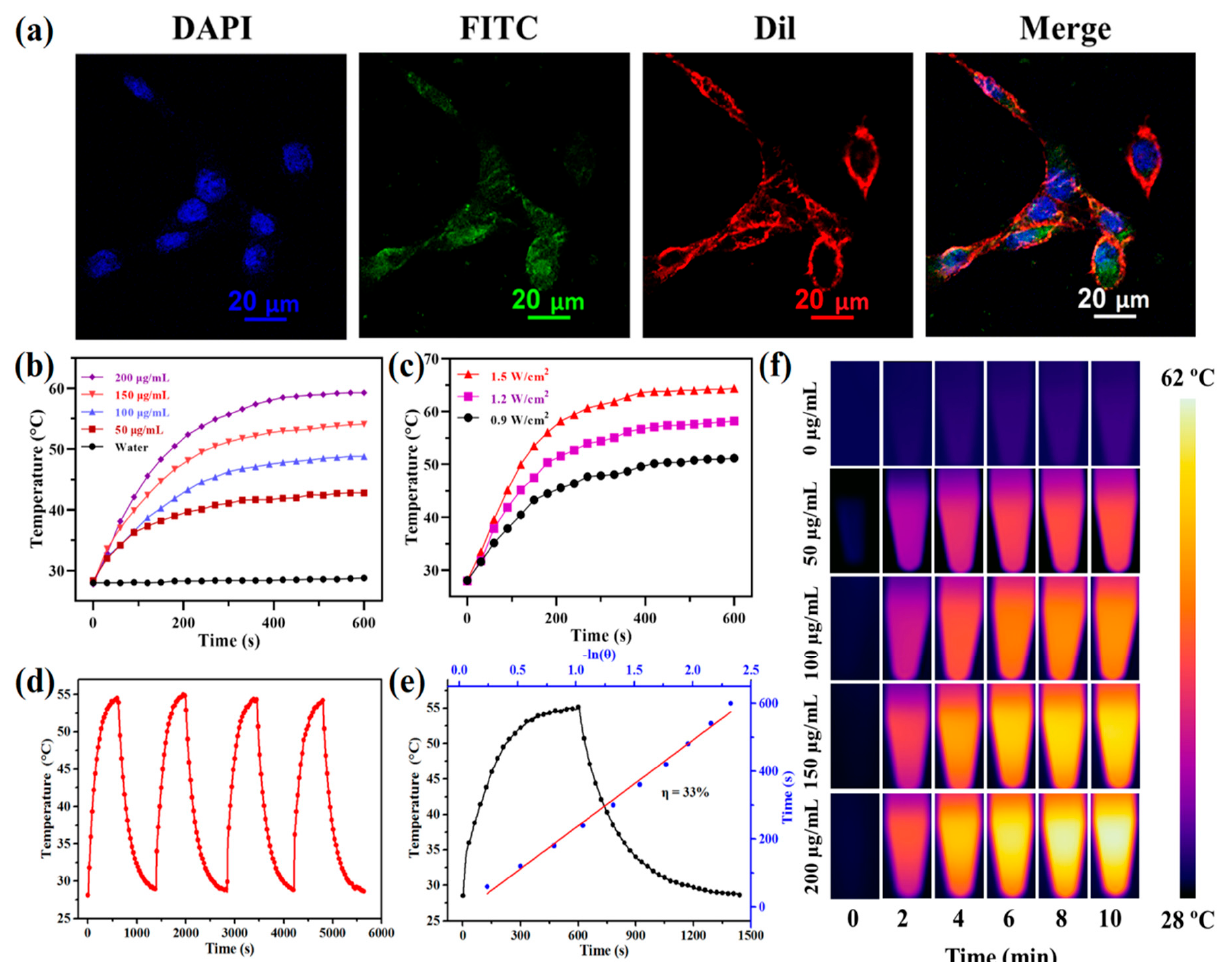
Figure 4. ( a ) Confocal microscopy images of intracellular distribution of COS modified PF127@Au- MnO HNPs for 6 h. Blue fluorescence shows 2-(4-Amidinophenyl)-6-indolecarbamidine dihydrochloride (DAPI) labeled nuclei, green fluorescence indicates FITC-labelled HNPs, red fluorescence represents cell membrane stained by 1,1’-dioctadecyl-3,3,3’,3’-tetramethylindocarbocyanine perchlorate (Dil), and merge is the combined effect to observed complete cell. ( b ) Photothermal conversion profile at various concentrations (50, 100, 150, and 200 µ g mL − 1 ) of prepared Au-MnO HNPs irradiated by 808 nm laser with 1.2 W/cm 2 power intensity, ( c ) temperature rising graph of 200 µ g mL − 1 HNPs solution using variable laser power intensity (0.9, 1.2, and 1.5 W cm − 2 ), ( d ) cyclic photothermal stability tests of 150 µ g mL − 1 HNPs solution under 1.2 W cm − 2 laser irradiation, ( e ) heating and cooling curves of 150 µ g mL − 1 HNPs solution under 1.2 W cm − 2 laser irradiation with linear fitting time data obtained from the cooling period and ( f ) photothermal images using an infrared camera. The scale bar is 20 µ m.